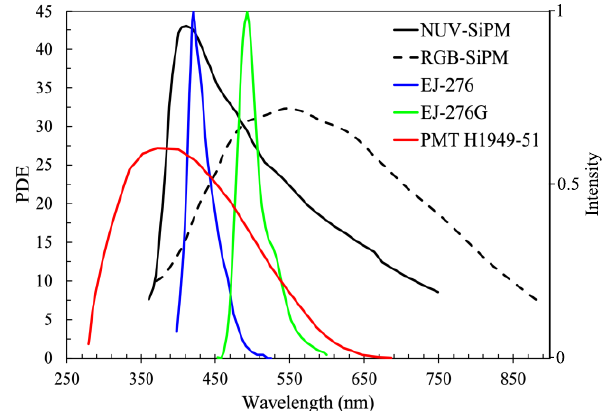
Fig. 1. Photon detection efficiency (PDE) corresponding to the NUV and RGB SiPM (left axis) compared with the emission curves of the plastic scintillators (right axis). Quantum efficiency of the H1949-51 PMT is also given (left axis).